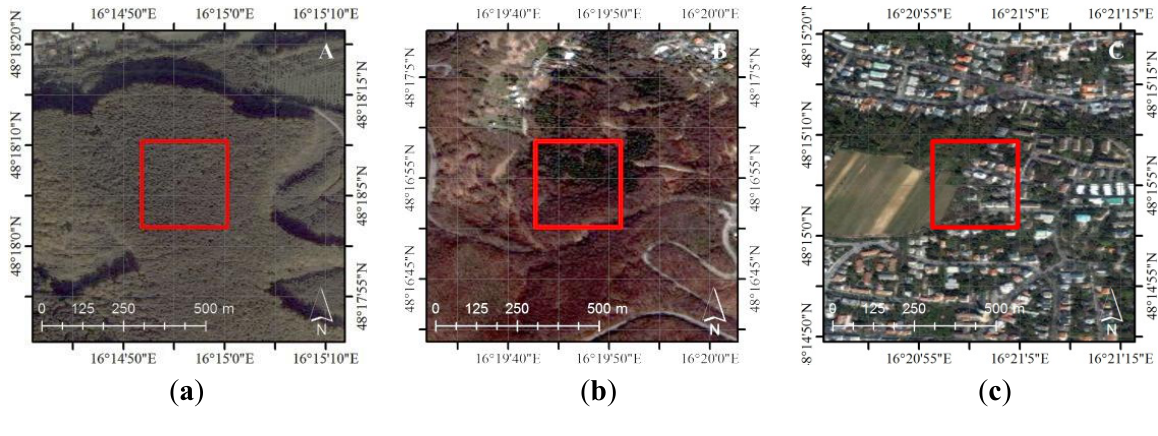
Figure 4. Illustration of different levels of pixel homogeneities. Examples are provided for Deciduous Forest ( a ), Deciduous Forest mixed with Evergreen Forest ( b ) and Urban mixed with Deciduous Forest and Cropland ( c ) LC classes as interpreted in the high resolution Google Earth images. (a) high homogeneity, (b) medium homogeneity, and (c) low